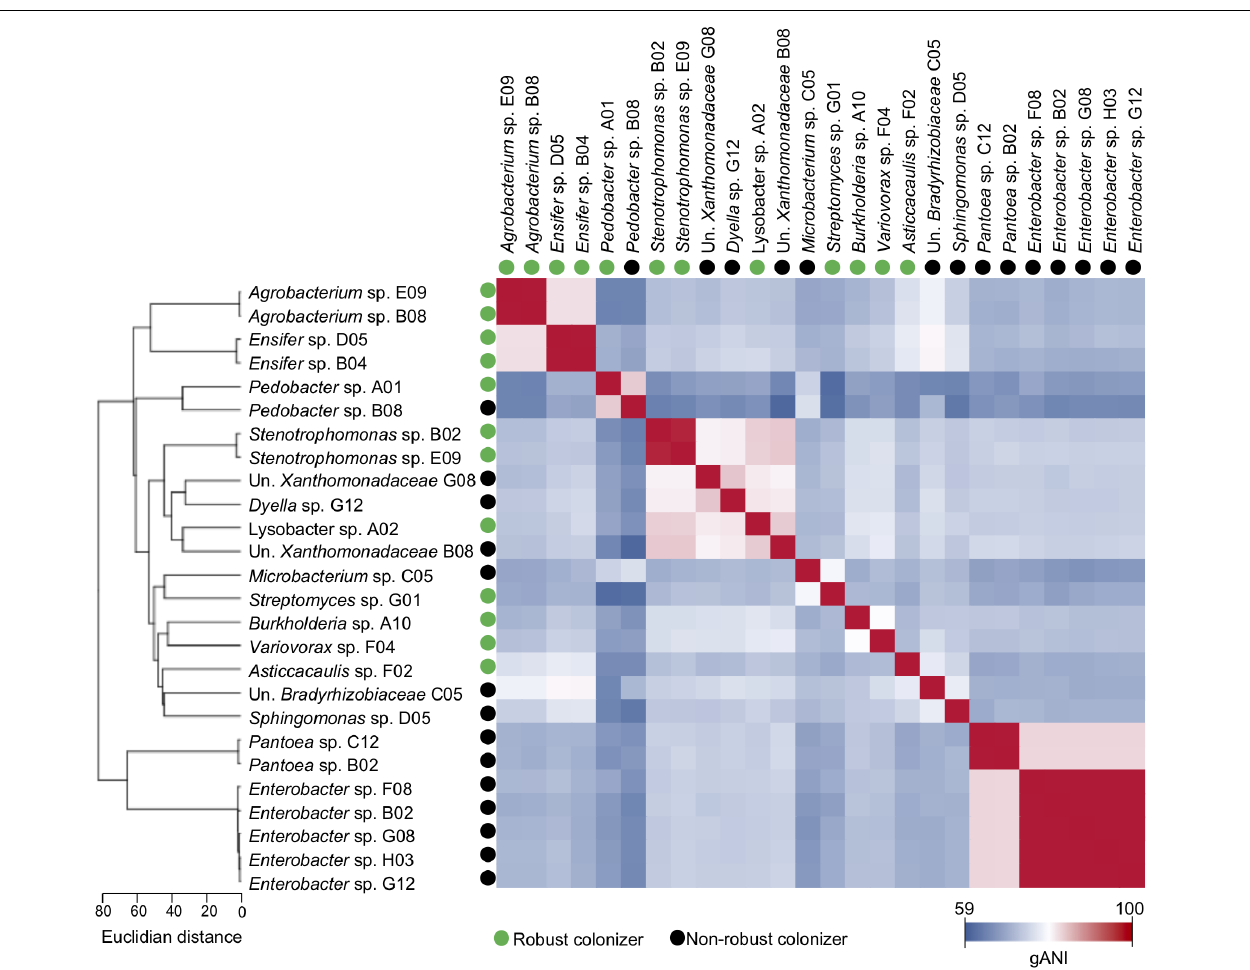
FIGURE 2 | Robust colonization lifestyle is found in genetically distant bacteria. The SynCom is comprised of 17 community-based isolates harboring 26 strains that span 16 different genera. Calculation of whole-genome identity between pairs of genomes revealed no correlation between robust colonization lifestyle and genome relatedness. Distance and relatedness of bacterial genomes were calculated based on whole-genome average nucleotide identity (gANI) between each pair of